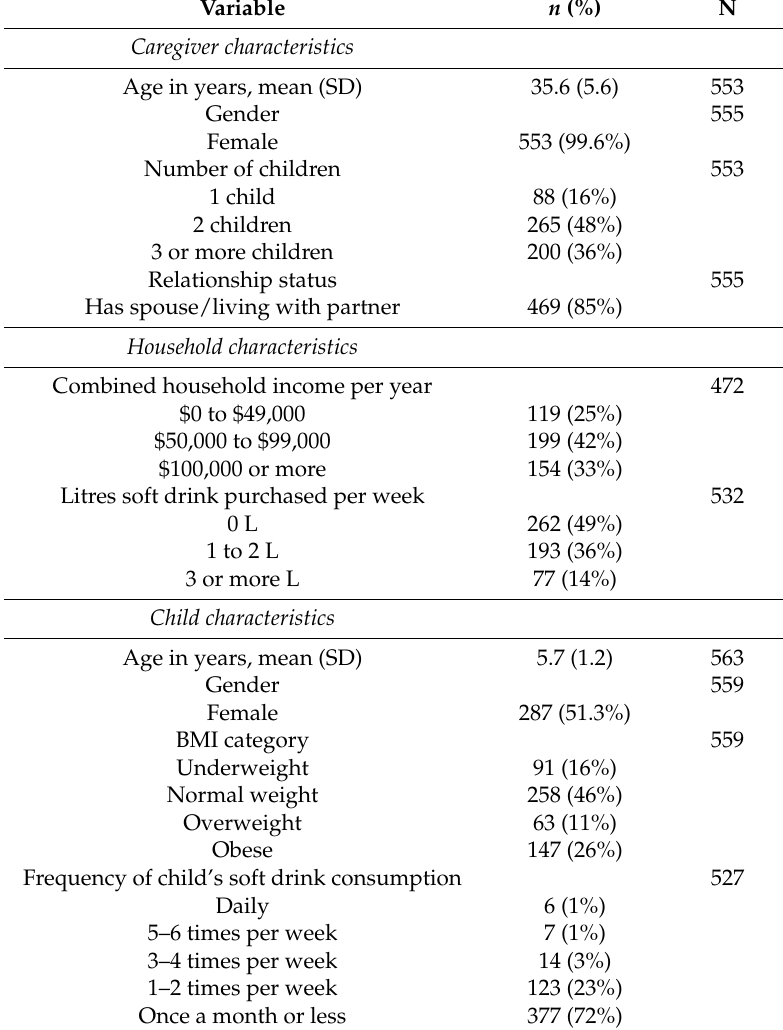
Table 1. Key sample